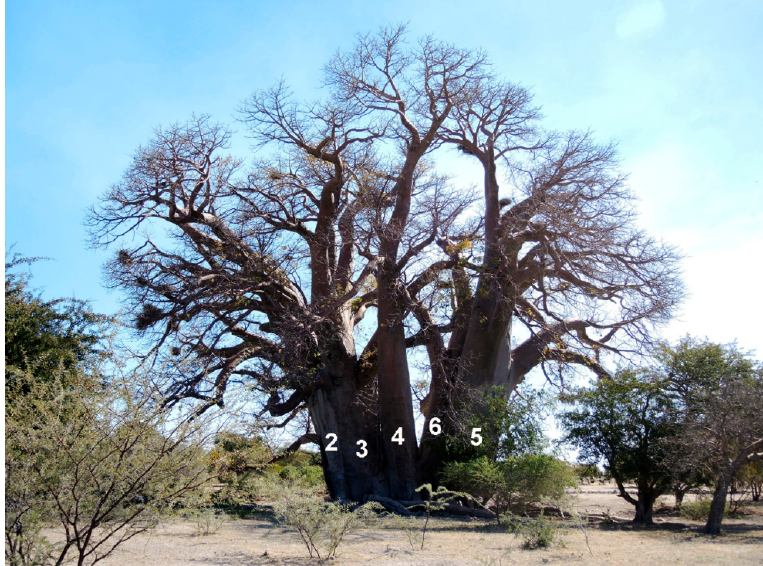
Figure 2. Another general view of the standing Chapman baobab taken from the east, with stem numbering.